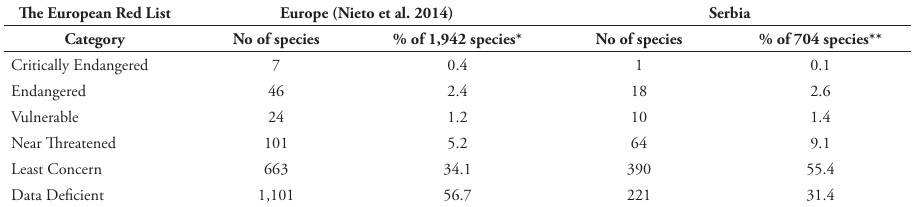
Table 2. Summary of numbers and proportion of bee species within each category of threat. The European Red